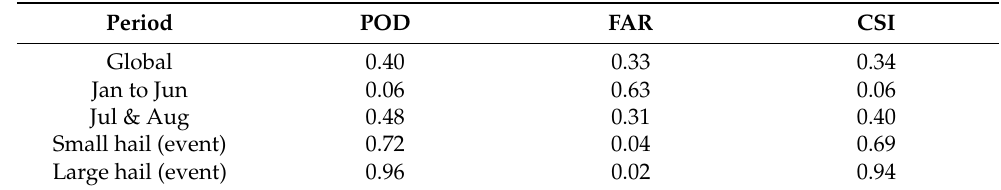
Table 2. Skill scores (POD, FAR, CSI) for the global dataset, for the months of January to June, and from July to